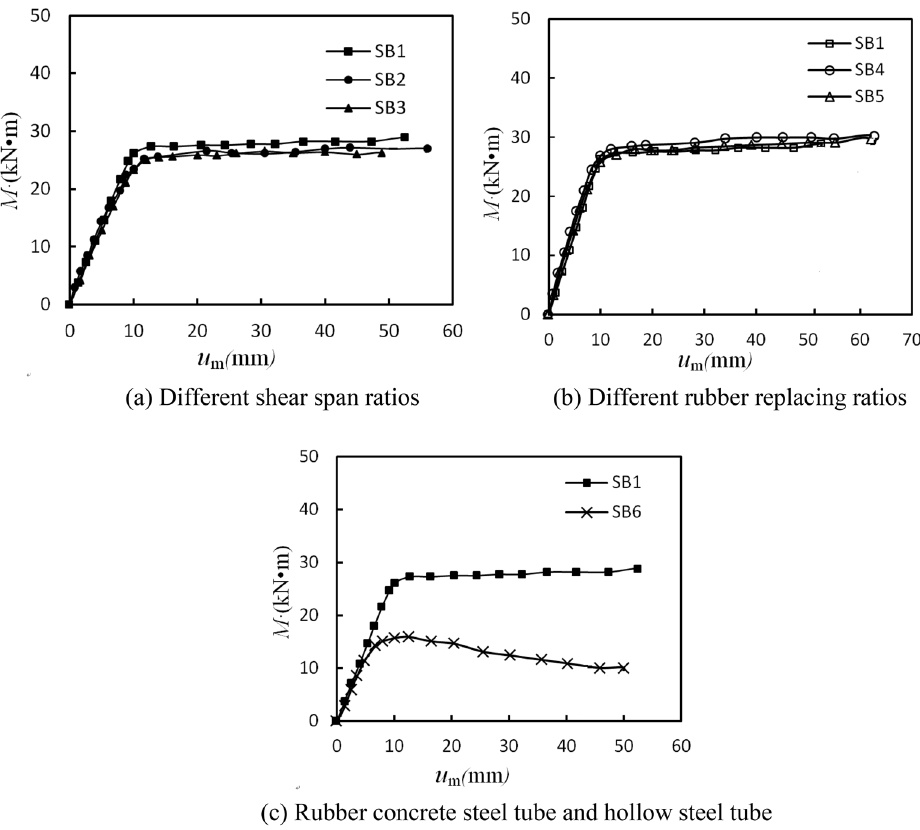
Figure 8. Bending moment ( M )- deflection ( u m ) curves of